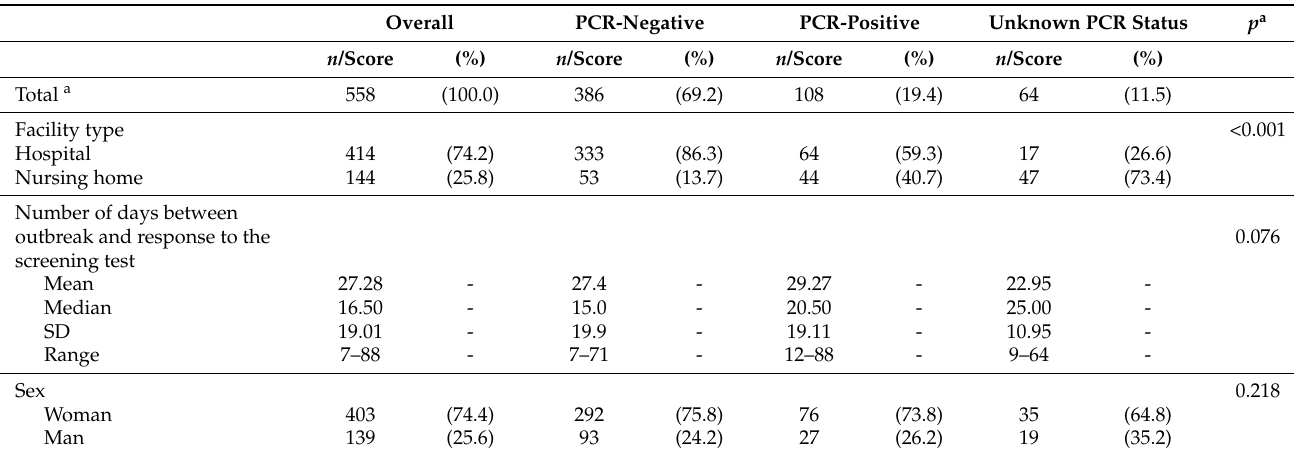
Table 1. Participants’ sociodemographic